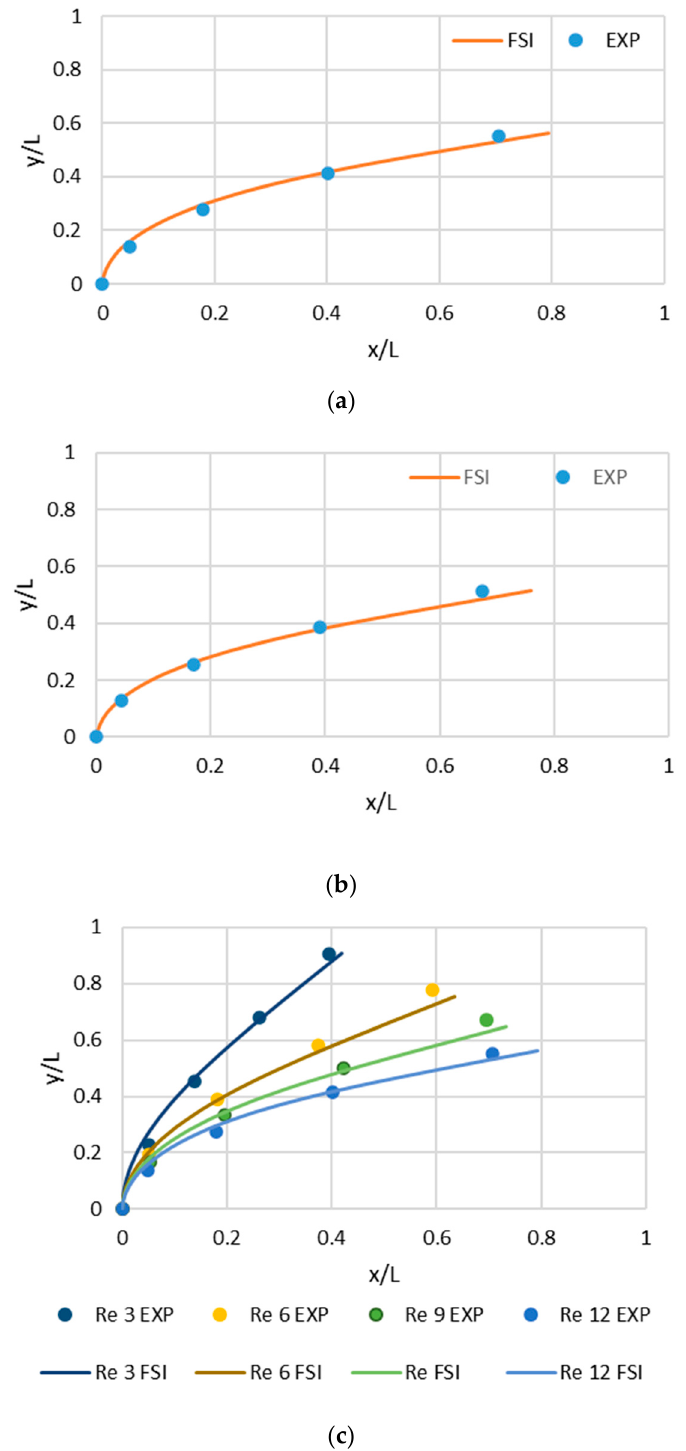
Figure 6. Flap bending; ( a ) Re = 12 leading edge; ( b ) Re = 12 trailing edge; ( c ) Leading edge as a function of Reynolds number, thickness 5 mm.